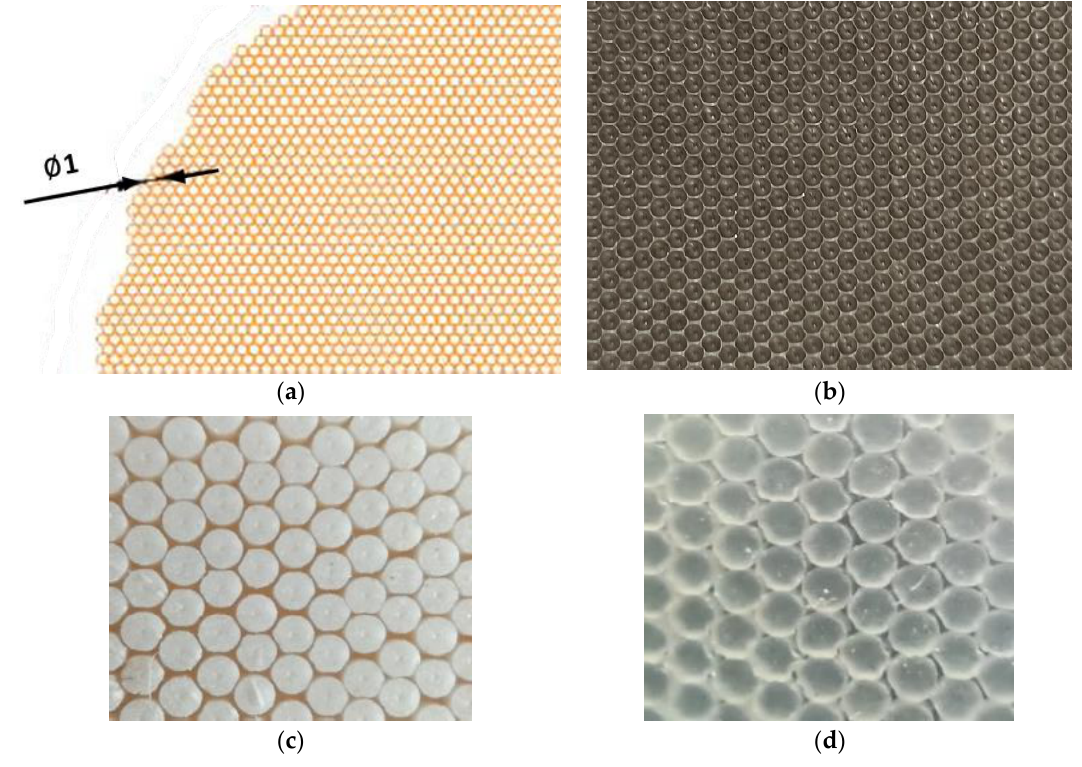
Figure 1. ( a ) Design of a geometrised aluminium mould; ( b ) actual geometrised aluminium mould used in curing; ( c ) actual sample made of butyl rubber; and ( d ) actual silicone rubber sample. The setup scheme for the measurements is provided in the Figure